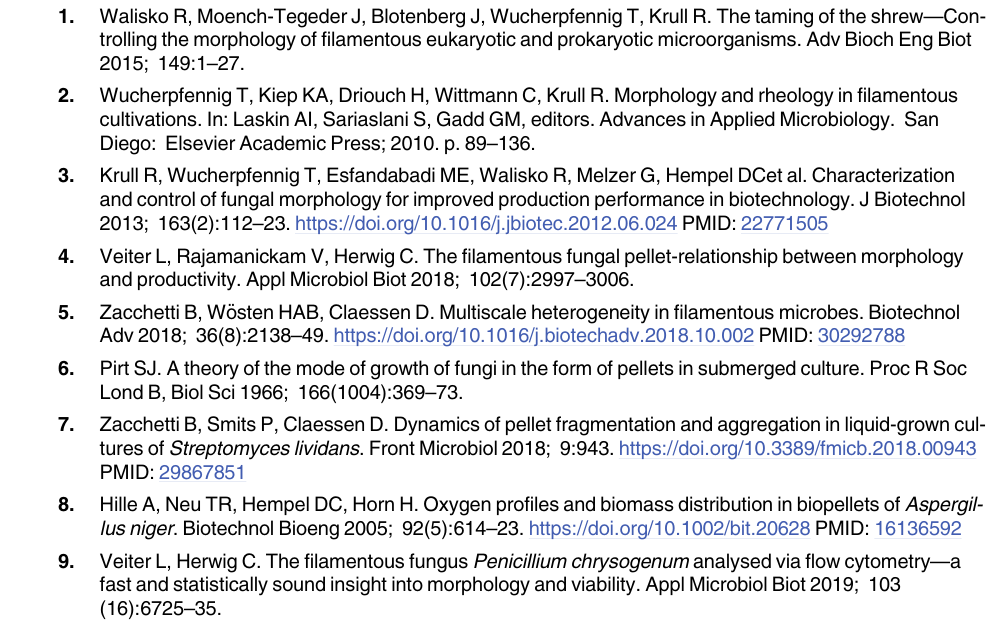
fluorescence (PI positive) signals. Total fluorescence signals represent the area underneath the curve with respect to flow cytometry signal profiles as depicted in Fig 6. S2 Fig. Normalized number-density-distribution q0(d q3(d ) of pellets analyzed through microscopic image analysis per day. q0(d a from cultures (a) without and (b) with glass beads and q3(d out and (d) with glass beads. S1 Table. Single-factor analysis of variance (ANOVA). Statistical analysis of study results with α =